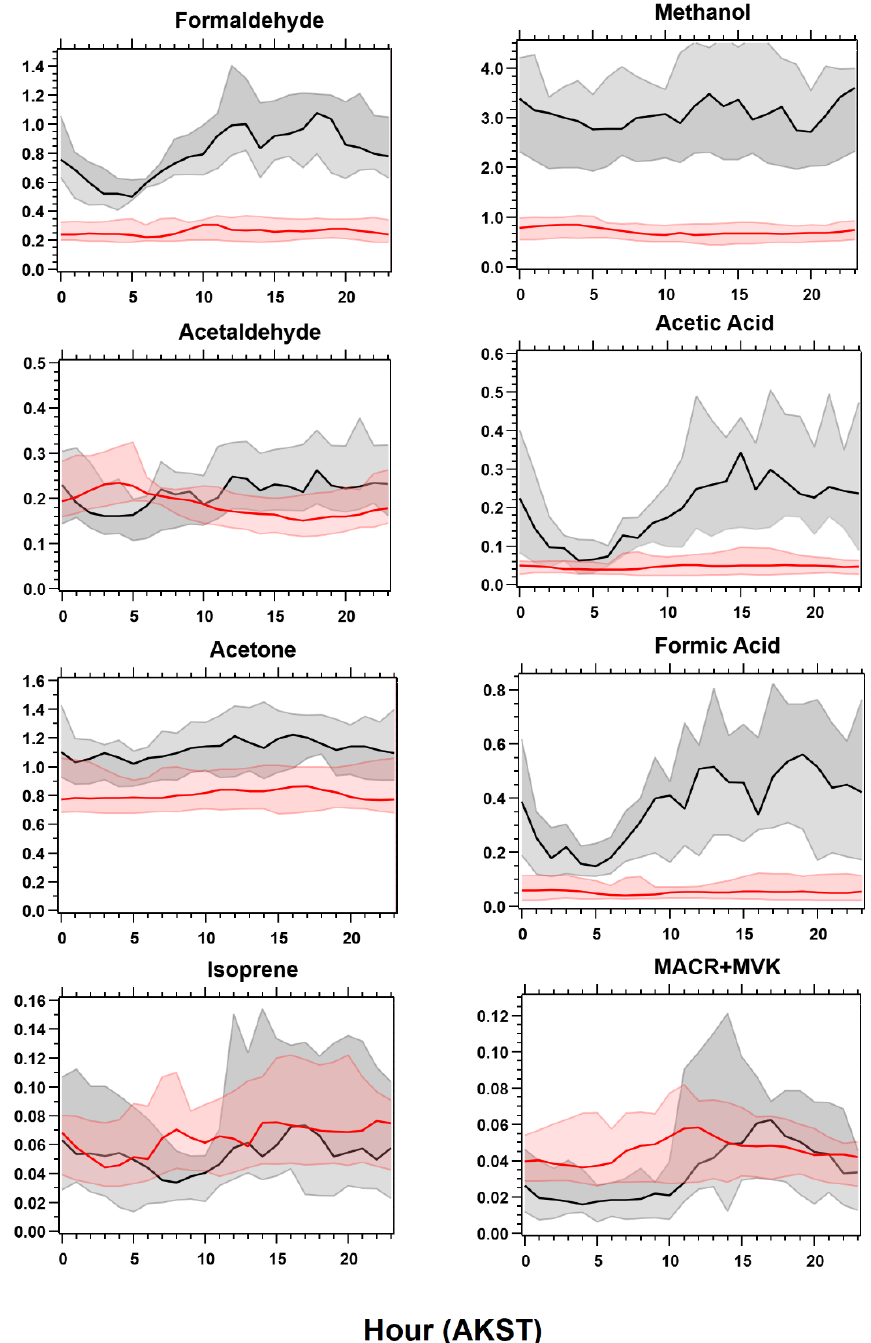
Figure 5. Diel cycles for select measured (black) VOCs compared to GEOS-Chem + MEGANv2.1 simulations (red). Solid lines represent median values, with shaded areas representing the 25th to 75th percentile